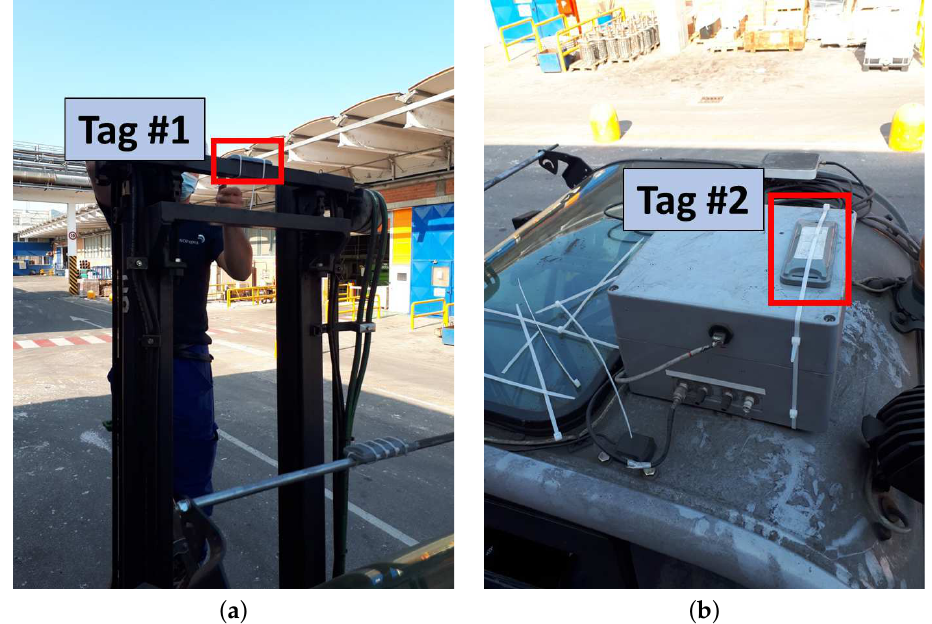
Figure 6. RFID tags placed on the forklift. ( a ) Tag placed on the upright, and ( b ) tag placed on the forklift top.